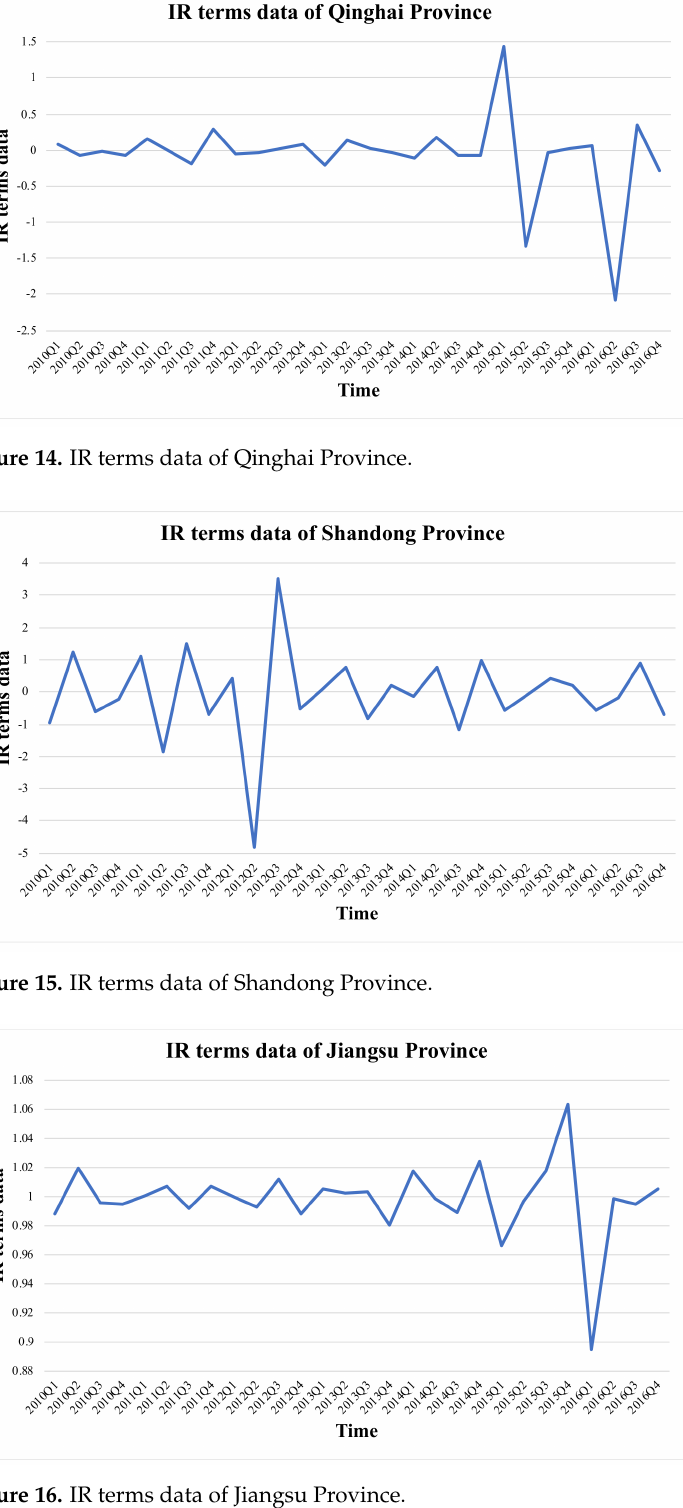
Figure 16. IR terms data of Jiangsu